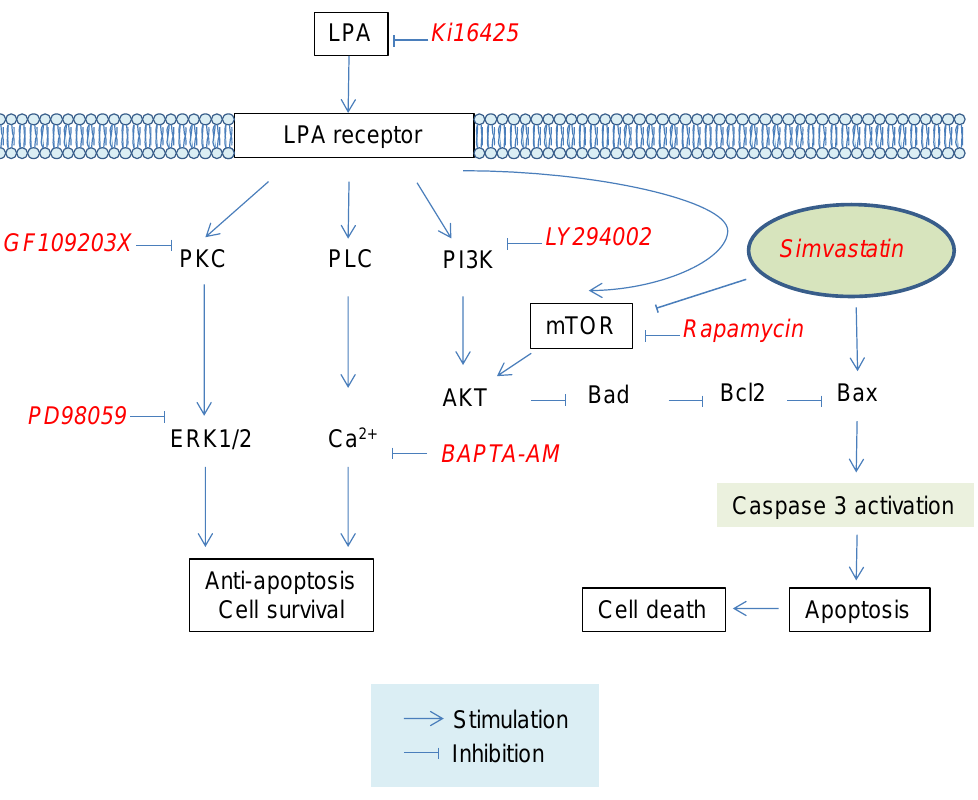
Figure 6. Proposed signaling pathways for the protective effect of LPA against simvastatin-induced cytotoxicity in L6 cells. LPA receptor activation by LPA may influence PKC/ERK1/2, PLC/intracellular Ca 2+ mobilization, and mTOR/AKT pathways, leading to cell survival. Such cell survival effect